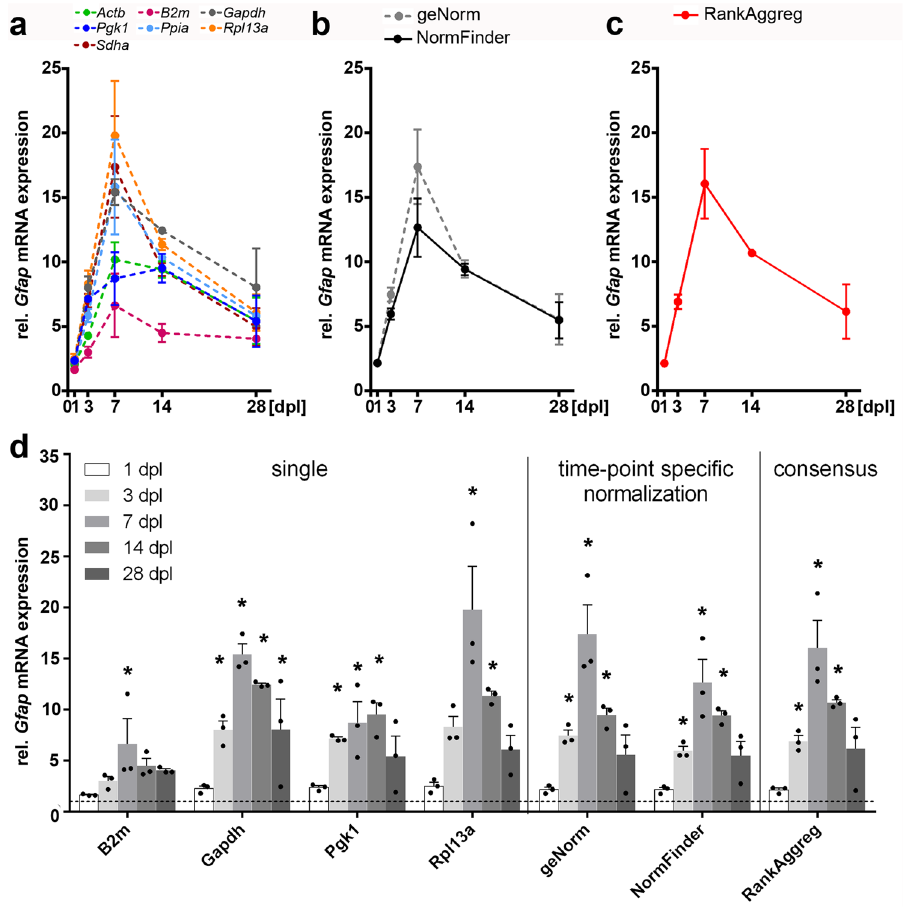
Figure 7. Influence of different normalization strategies for accurate quantification of Gfap mRNA expression levels in the dentate outer molecular layer after entorhinal denervation. ( a , d ) Normalization using a single reference gene resulted in different Gfap mRNA expression levels in the dentate outer molecular layer after entorhinal denervation. ( b , d ) In comparison, normalization using reference genes determined by geNorm or NormFinder for specific time-points after denervation showed a comparable time course and pattern of Gfap mRNA expression levels. ( c , d ) Results from both algorithms were combined using RankAggreg to obtain a consensus ranking for all time-points following denervation. dpl, days post lesion. Data are shown as mean ± SEM. N = 3 animals per time point. Statistics: One-way ANOVA, followed by Dunnett’s post-hoc test, with * p <